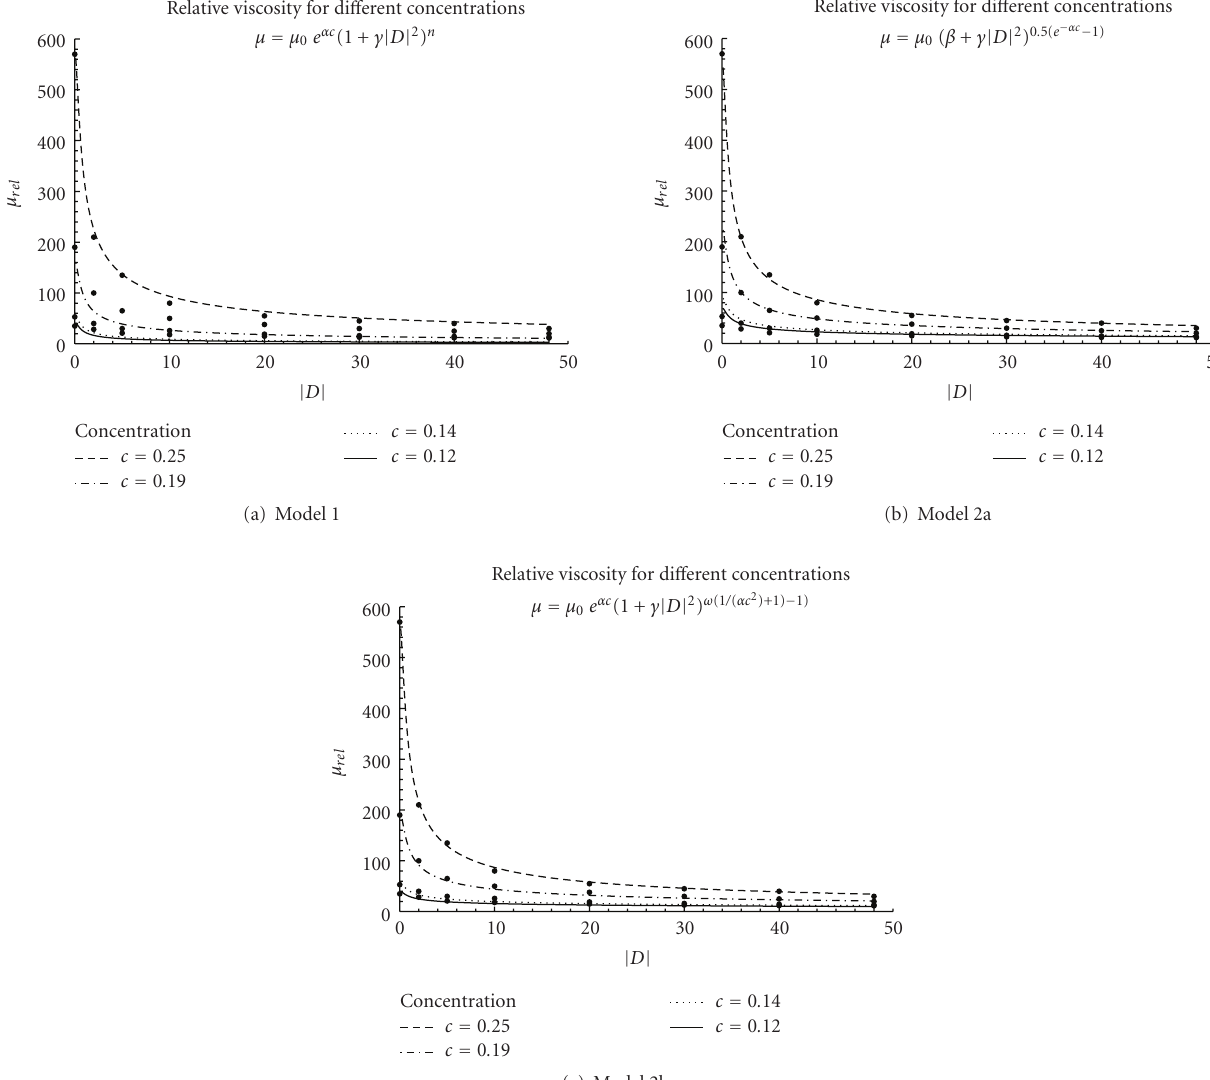
Figure 1: Relative viscosity against shear rate for di ff erent concentrations. Graphs of the relative viscosity for all the models show the fitted curves and the experimental data (points) which were taken for the fitting procedure. Here we use the notation from Ogston and Stanier [1] for μ rel = μ/μ ref , where μ ref is defined by the viscosity of the glycerol solution.